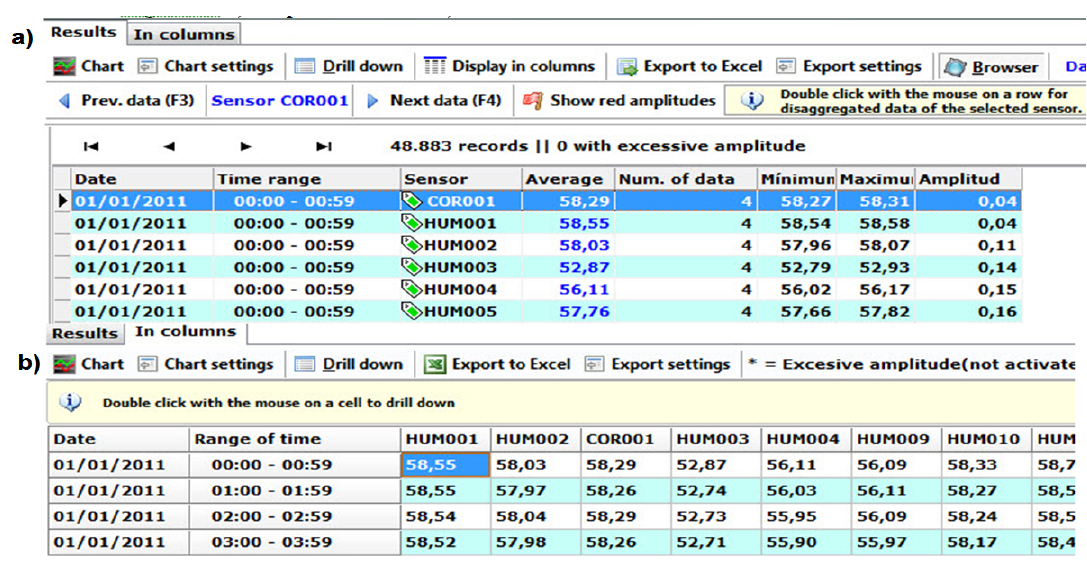
Figure 8. ( a ) Sequential view; ( b ) Column view.